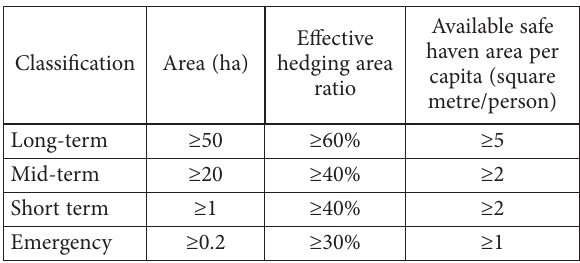
Table 3. Classification table of design requirements for effective avoidance area of urban disaster prevention and